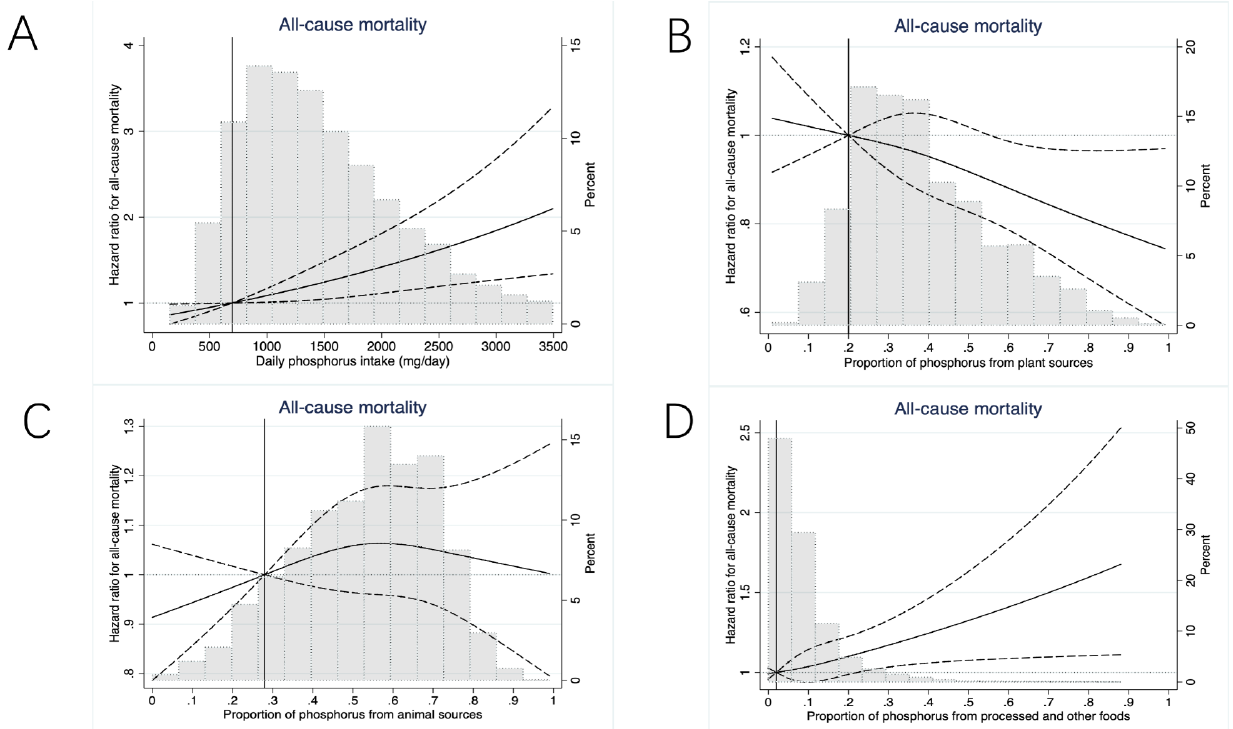
Figure 2. Adjusted restricted cubic splines for the association between phosphorus intake ( A ), proportion of phosphorus from plant ( B ), animal ( C ), processed and other sources ( D ), and all-cause mortality.